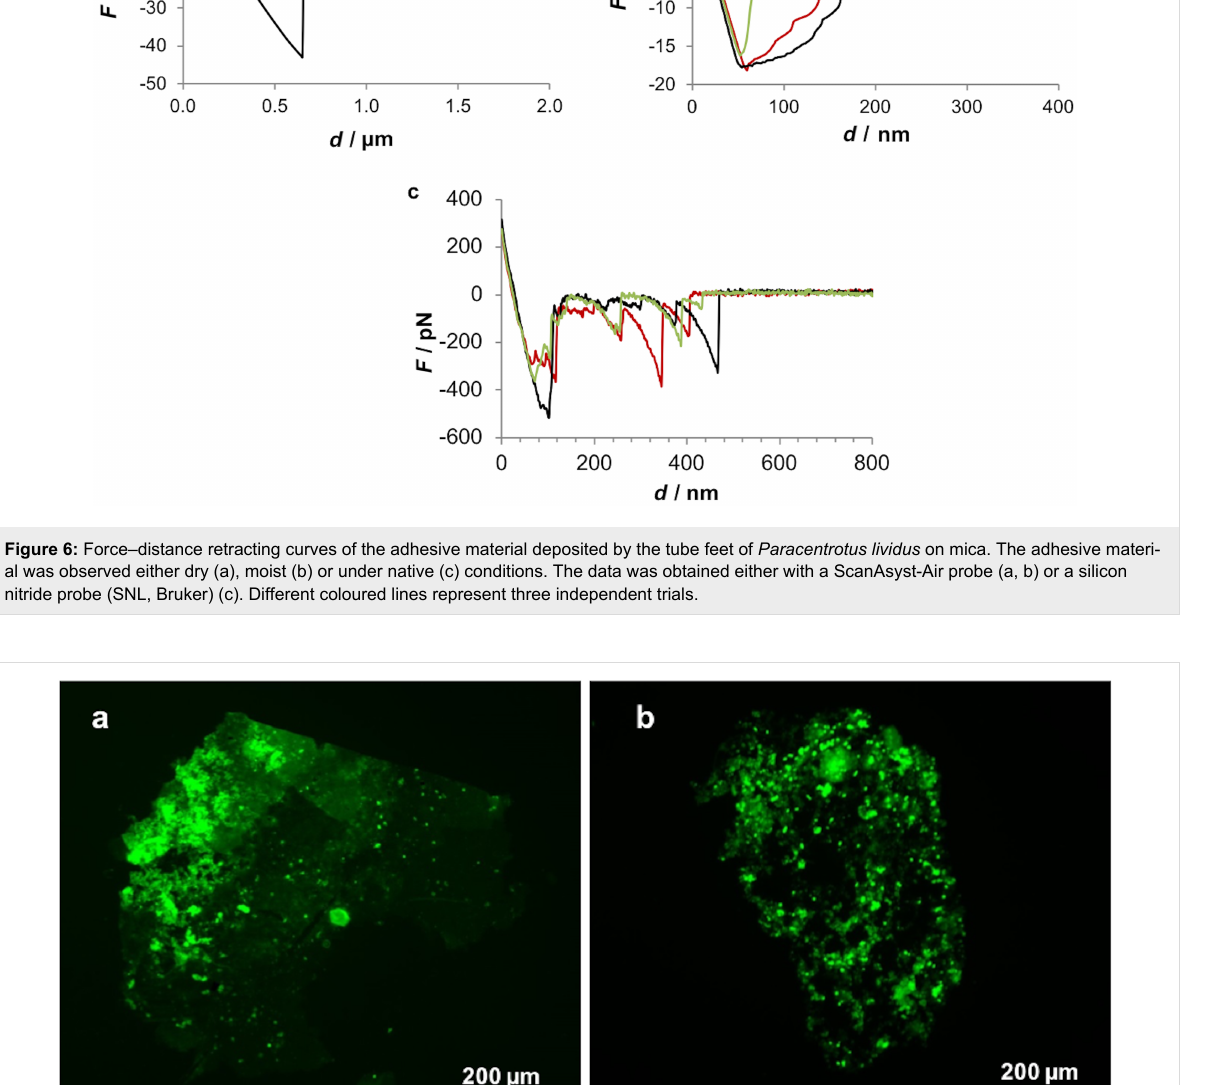
Atomic force microscopy